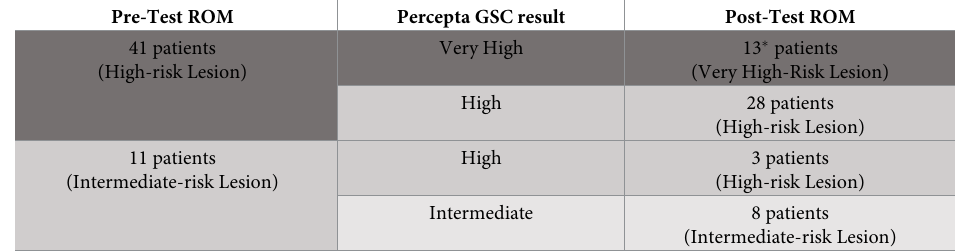
Table 4. Patients � with intermediate- and high-risk lesions that were up-classified by Percepta GSC and under- went additional procedures prior to malignant diagnosis.